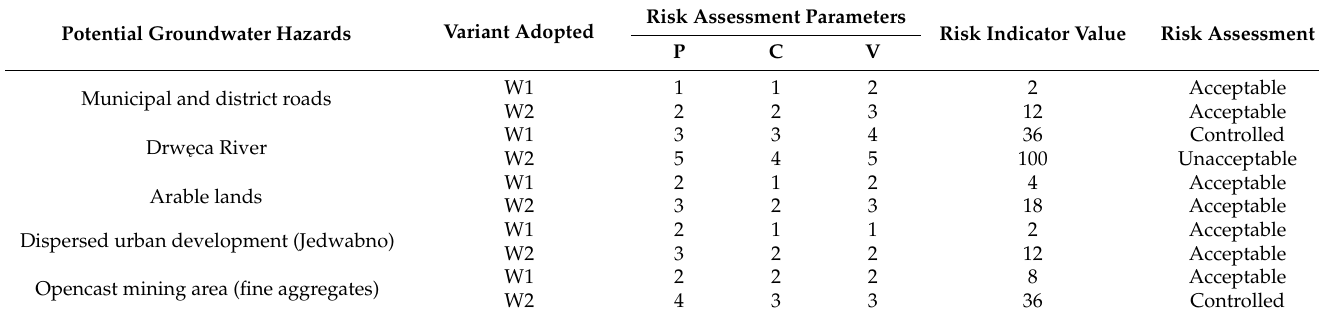
Table 7. Risk assessment for the infiltration intake in Jedwabno.